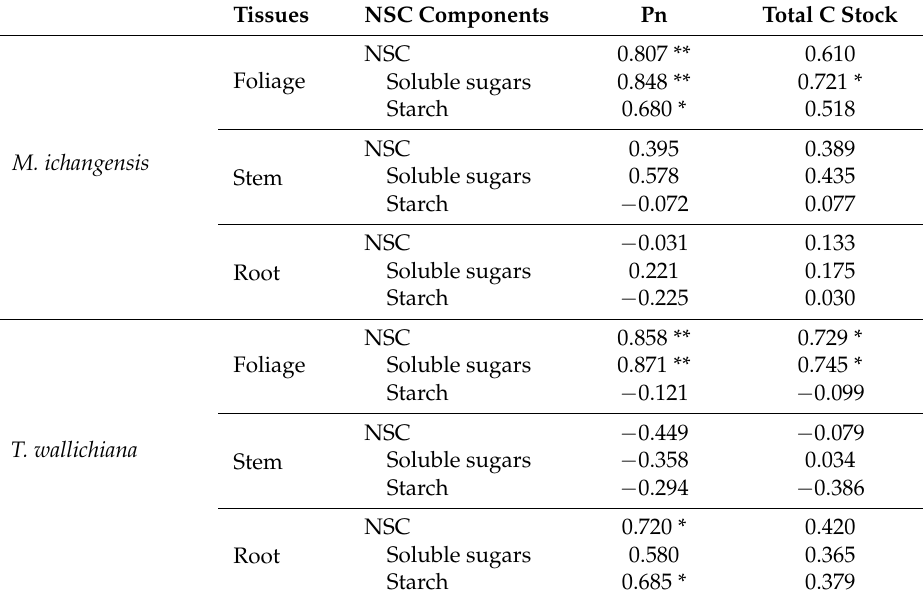
Table 1. Correlation coefficients between NSC/soluble sugars/starch concentration and Pn/total C stock for each of the tissues of the two species.